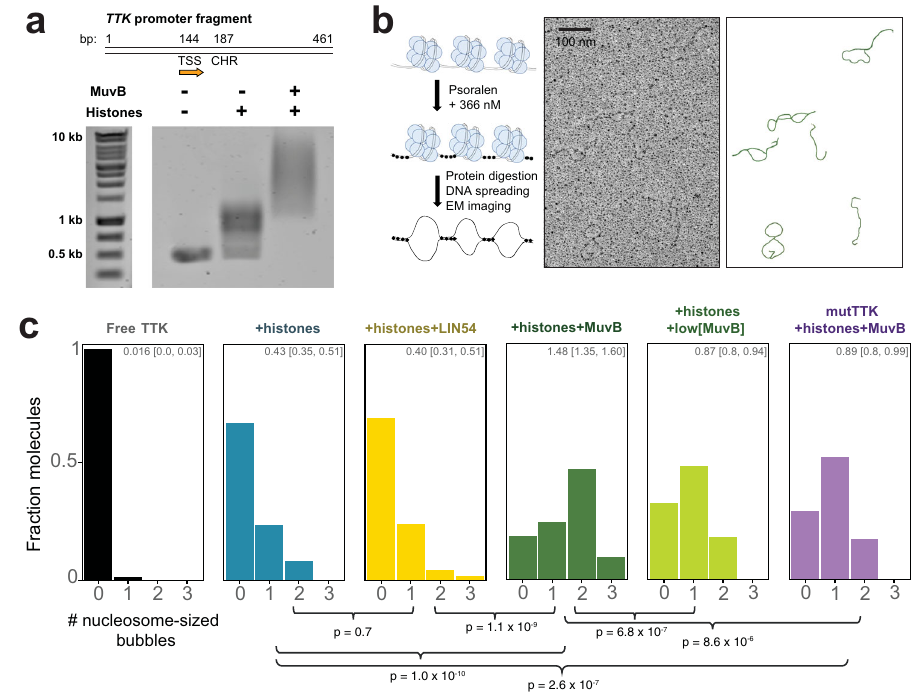
Fig. 5 MuvB stabilizes nucleosomes on a reconstituted cell-cycle gene promoter. a Reconstitution of the TTK promoter with nucleosomes and MuvB. At top is a schematic of the promoter fragment used in these experiments with the transcription start site (TSS) and CHR site indicated. The indicated proteins were refolded with a 461 bp fragment of DNA and the samples were analyzed by an agarose gel with ethidium bromide staining. The assay was replicated twice with similar results. b Schematic representation of the protocol for cross-linking and imaging (left) and example electron microscopy micrograph (middle) with corresponding traced molecules (right). c Histograms showing the fraction of DNA molecules containing the indicated number of nucleosome-sized bubbles for a sample of 100 + analyzed DNA molecules. The MuvB concentration used in the reaction was 1.3 μ M, whereas low[MuvB] corresponds to 0.15 μ M. The number at the top of the box indicates the average number of nucleosome-sized bubbles per DNA molecule with 95% con fi dence interval in brackets. These statistics were computed using bootstrapping with 10,000 iterations of resampling. Histograms were fi t to a Poisson distribution and conditions were compared using an exact-Poisson test. p -values for comparisons of average number of bubbles ( λ of Poisson distribution) across conditions are reported below the